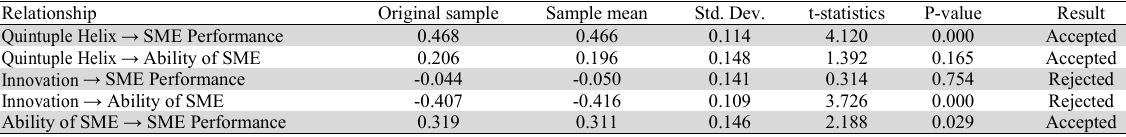
Result of bootstrapping Indonesia craft sub sector